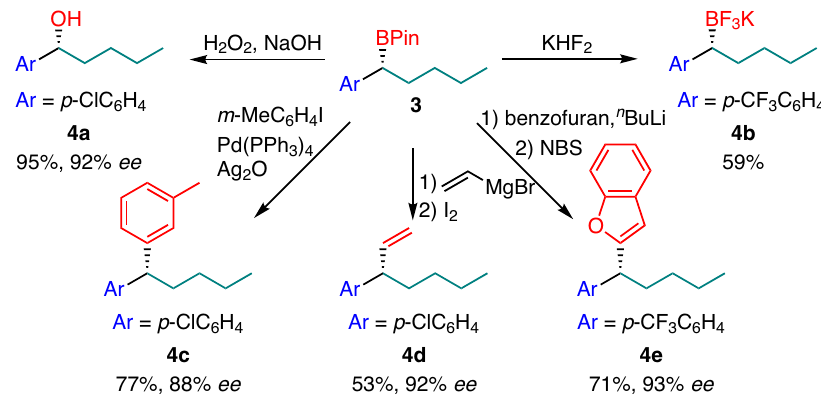
Fig. 4 Further application of the products. Derivatization of the chiral benzylic boronic